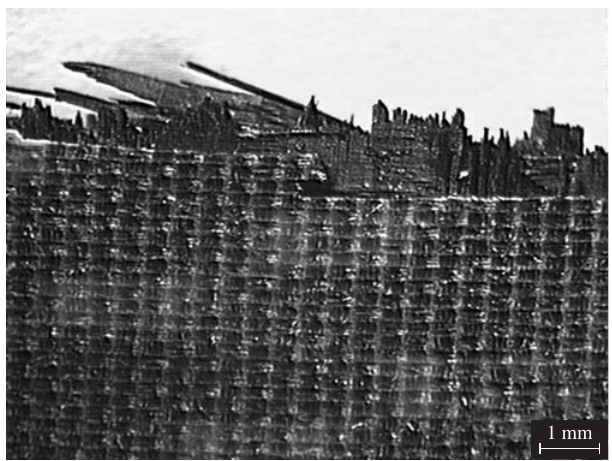
Figure 10. F155/8HS specimen after tensile test, (10x).